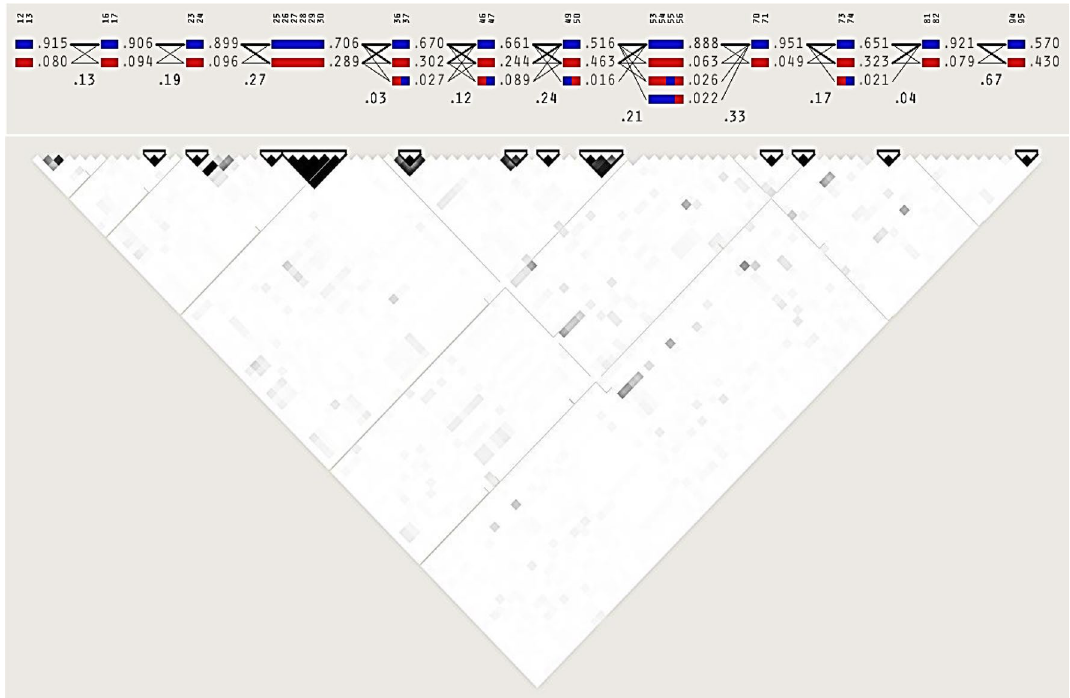
Figure 7. the Haplotype Blocks of the 99 associated SNPs with birth weight, daily gain, and body